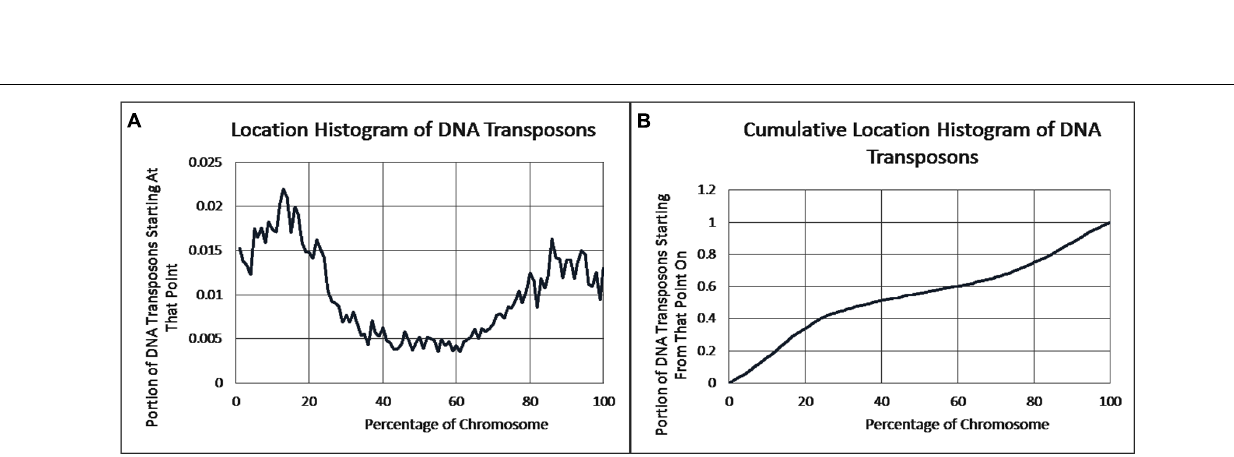
FIGURE 3 | DNA transposon locations. (A) The fraction of DNA transposons starting at each percent point of their chromosomes on average, as identified by RepeatMasker. (B) The cumulative probability distributions of DNA transposons on average. For each percentage point the fraction of clones starting at that point or further is